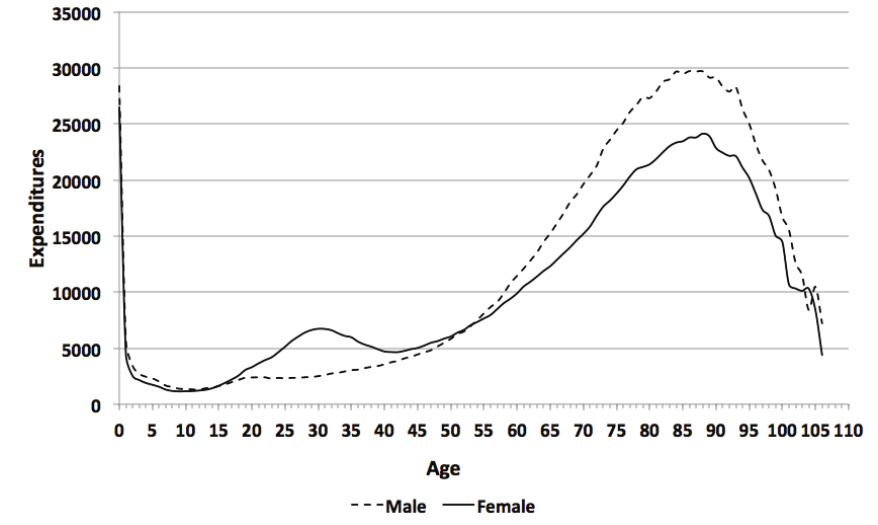
Figure 1: Hospital expenditures per capita measured in NOK by age,